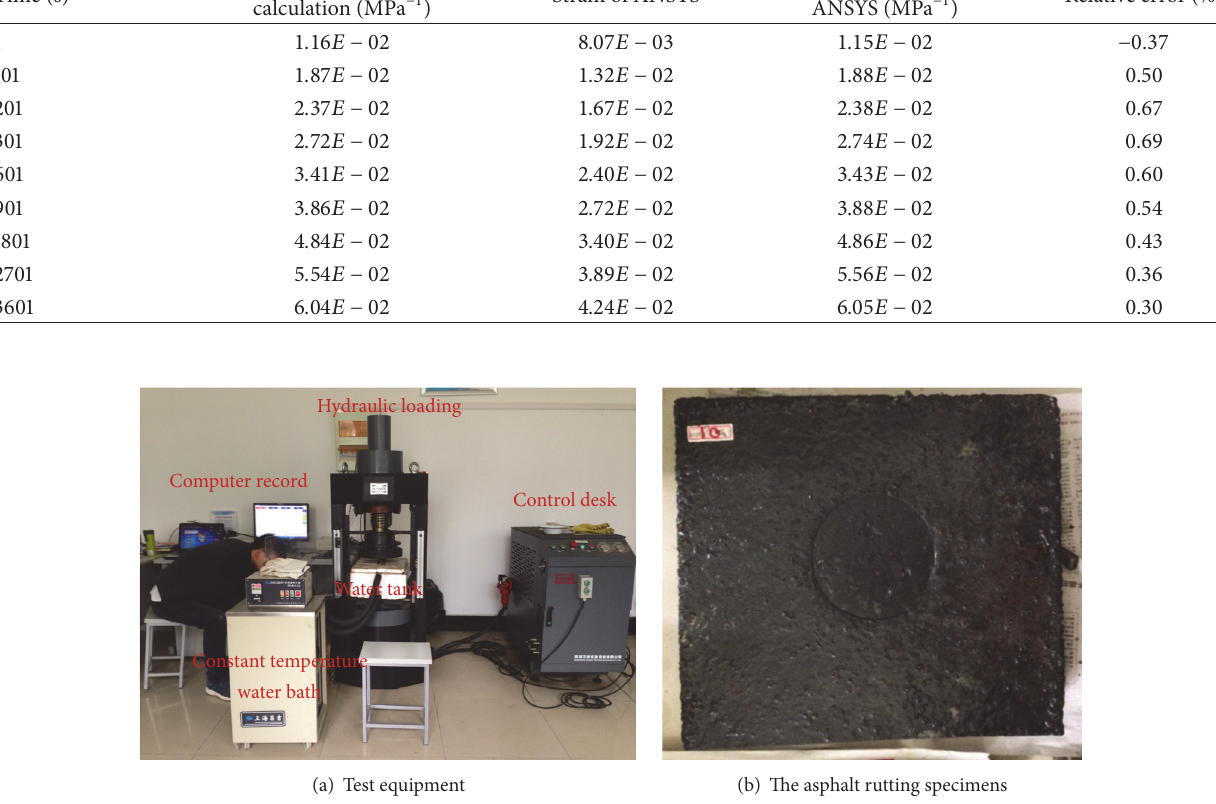
Figure 3: Uniaxial penetration tests on the asphalt rutting board.